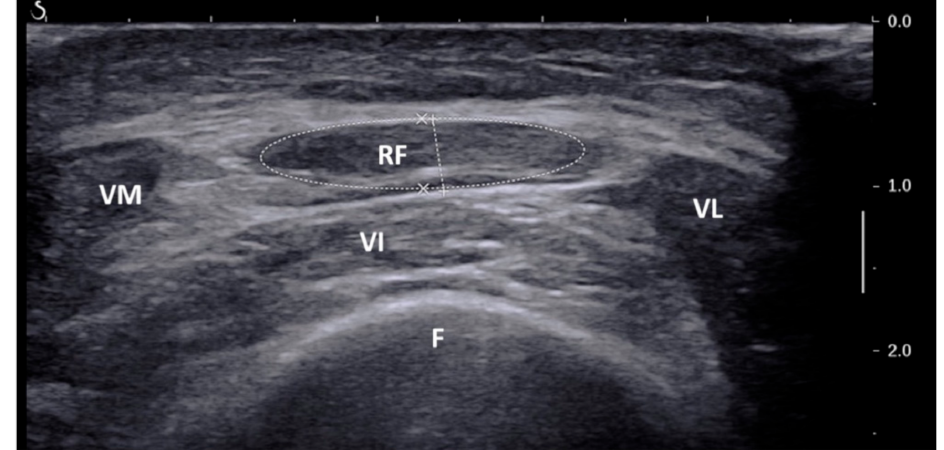
Figure 2. Ultrasound image of the rectus femoris muscle with definition of cross-sectional area (dashed line); RF: rectus femoris; VI: vastus intermedius; VL: vastus lateralis; VM: vastus medialis; F: